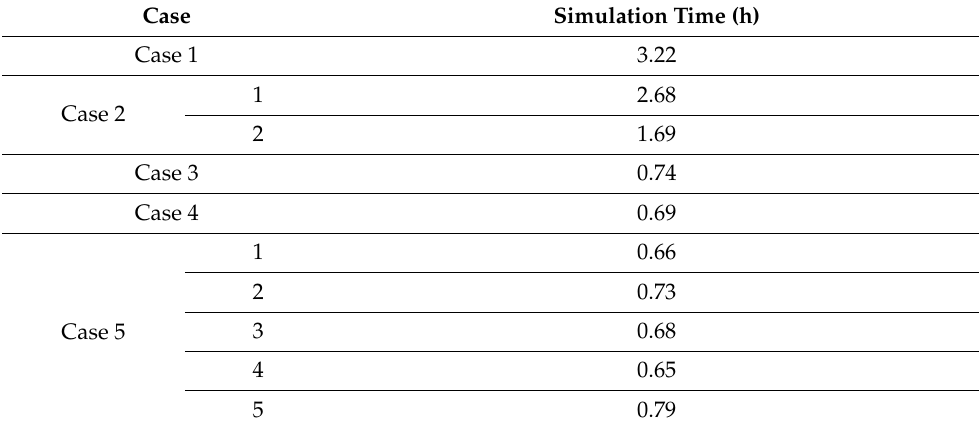
Table 5. Parallelization performance evaluation method